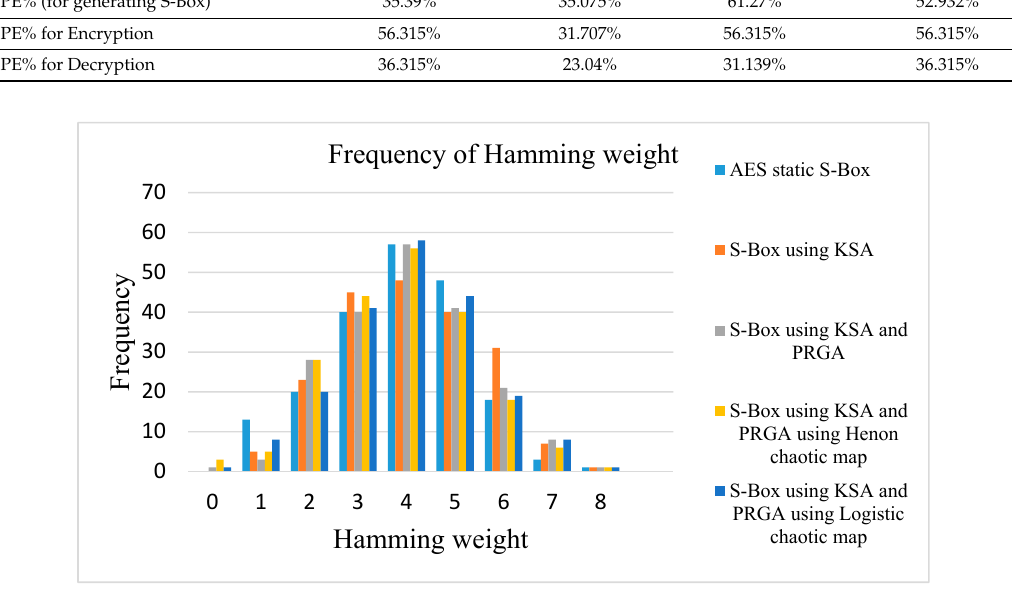
Figure 8. Hamming weights: a comparison between the five S-Boxes with the key